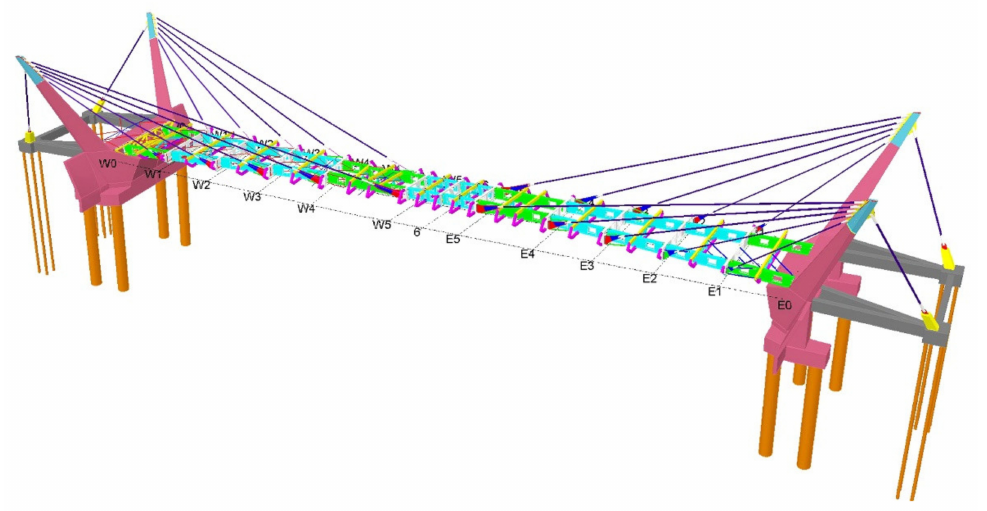
Figure 9. 3D BIM model of the